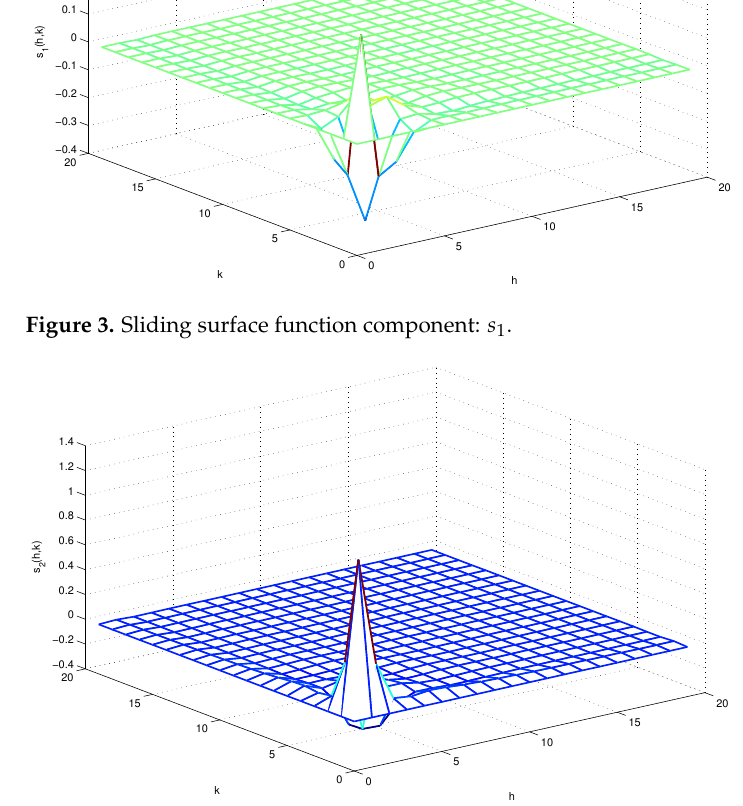
Figure 4. Sliding surface function component: s 2 .